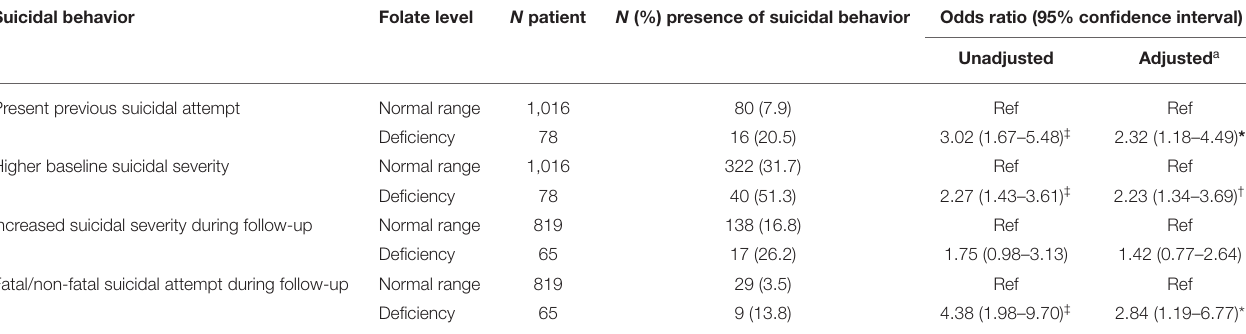
TABLE 5 | Associations of folate deficiency ( < 3ng/mL) with suicidal behavior in patients with depressive disorder. Suicidal